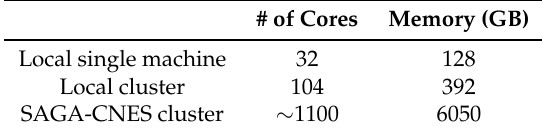
Table 1. Execution environment used for the tests. All these machines are under Oracle Java 8. # of Cores